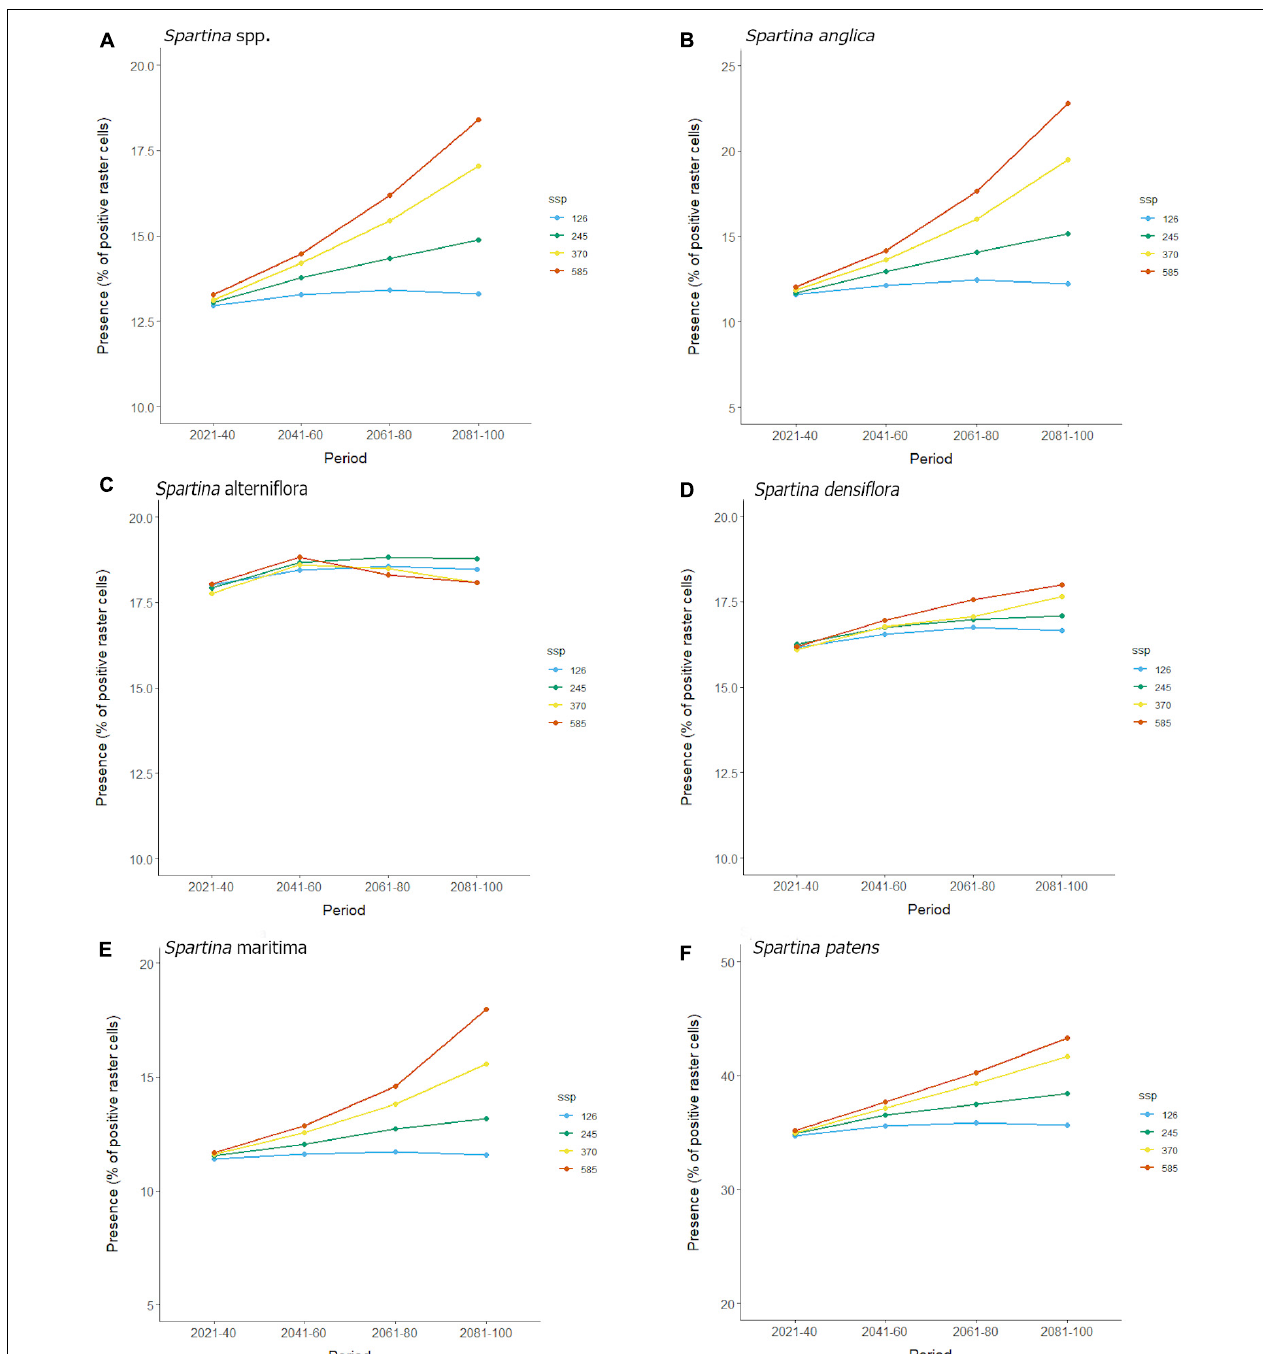
FIGURE 4 | (A) Worldwide presence status (%) over time (until 2100) for the whole Spartina genus and (B) for species S. alterniflora , (C) for S. anglica , (D) for S. densiflora , (E) for S. maritima , and (F) for S. patens in each specific CMIP6 Shared Socioeconomic pathway (i.e., SSP1-2.6, 2-4.5, 3-7.0, and 5-8.5). Percentage of presence status was quantified as the proportion of positive (i.e., greater than 0) raster map cells.